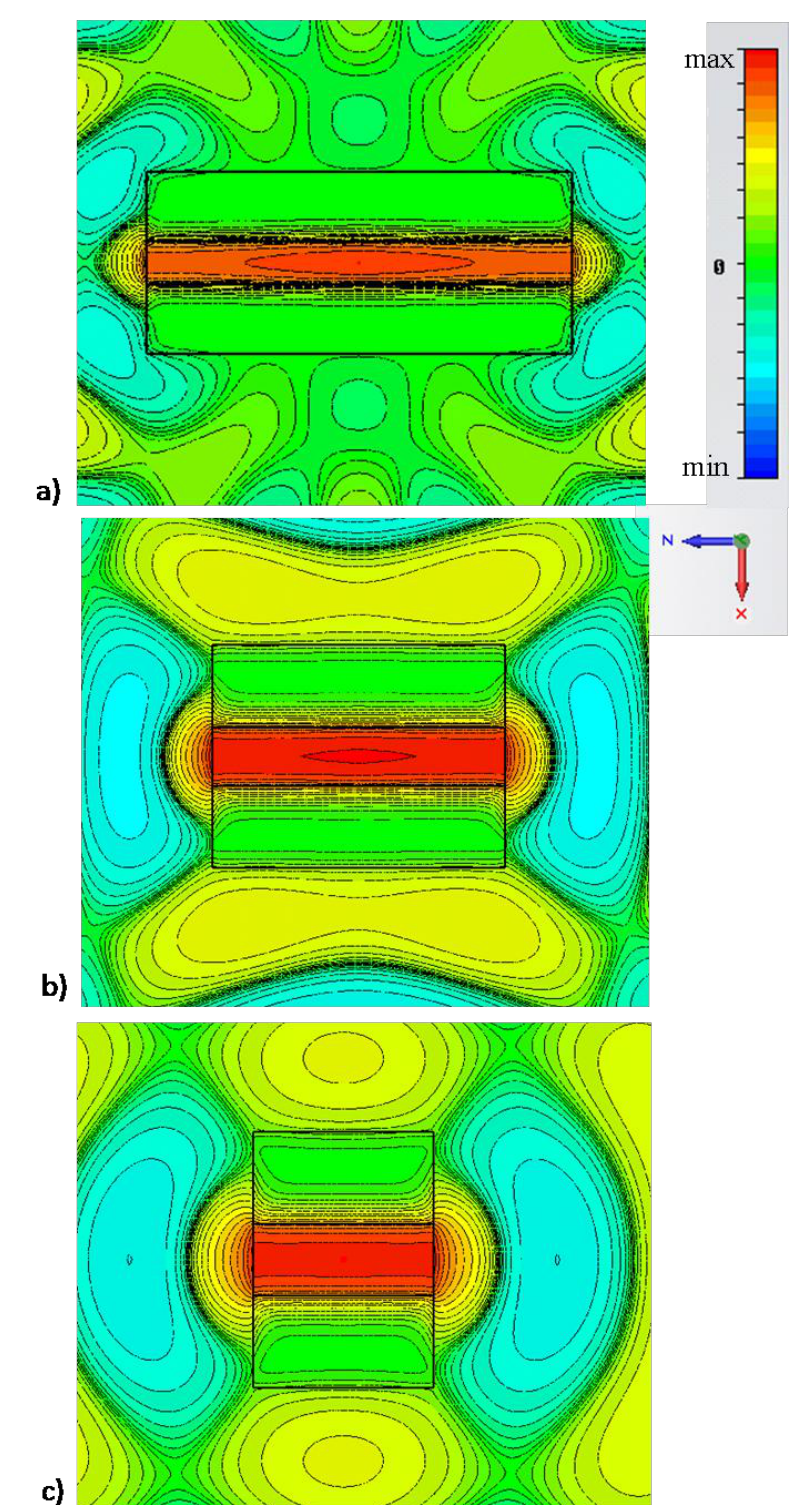
Figure 6. Analogous to Figure 5, but showing the top view for the different nanolauncher geometries of Figure